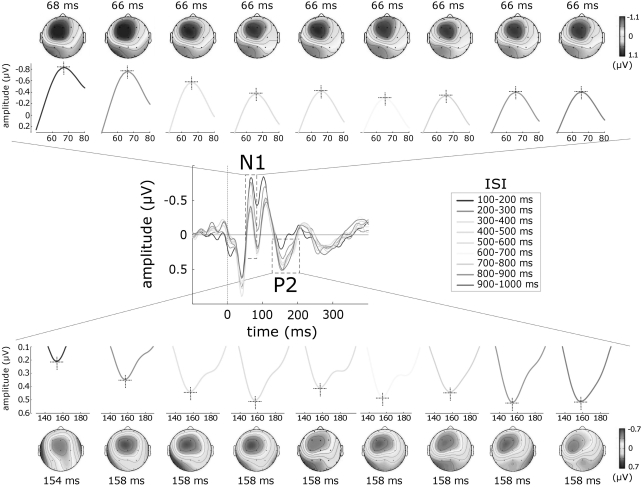
Effect of inter-stimulus interval (ISI) on the average amplitude of the auditory and somatosensory N1 and P2 waves.
y axis: amplitude (µV); x axis: ISI category. Both in the auditory and in the somatosensory modality the ISI had an opposite effect on the auditory and somatosensory N1 and P2: at shorter ISIs, the N1 displayed significantly larger amplitudes while the P2 displayed significantly smaller amplitudes. Error bars represent the variance across subjects (standard error of the mean). Asterisks highlight ISI categories in which the average peak amplitude was significantly different from the peak amplitude at the category ‘100–200 ms’ (* p<0.05; ** p<0.01).